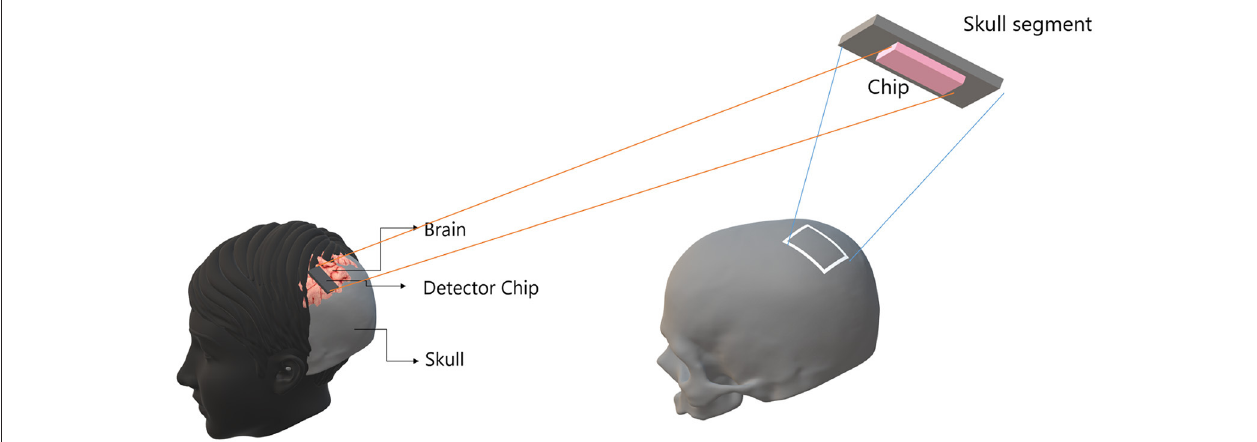
FIGURE 1 | A detector chip can be installed on the interior surface of the skull without touching the brain tissue, i.e., non-invasive. The environment of the closed skull in the head is sufficiently dark and therefore it is a suitable environment for the detection of UPE with the installed chip. The intensity of UPE is stronger close to the surface of the brain, which can be captured by chip on the